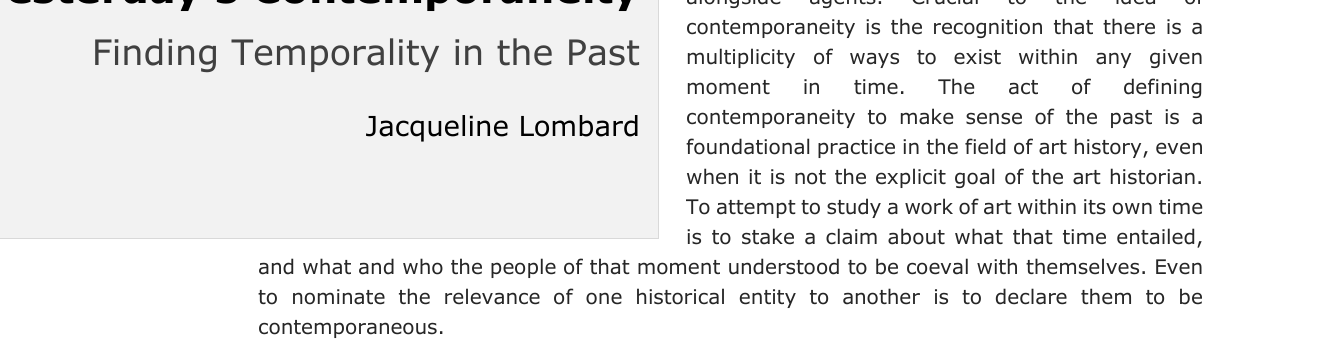
Contemporaneity: Historical Presence in Visual Culture